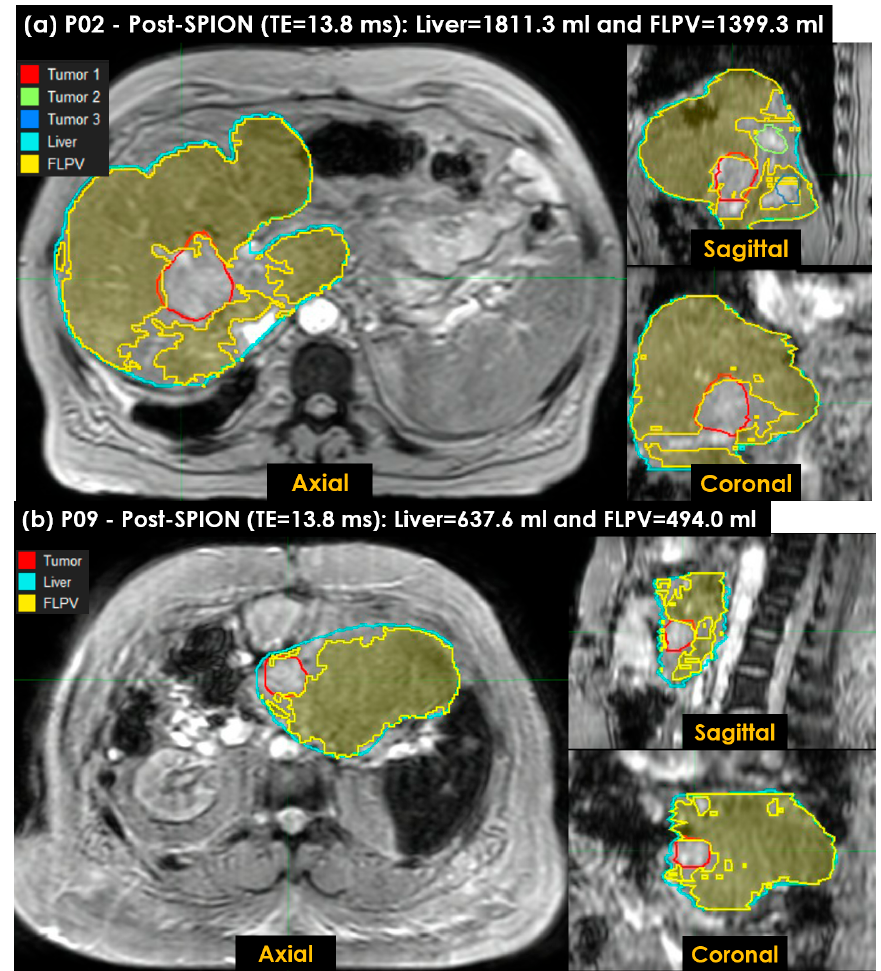
Figure 8. The functional liver parenchyma volume(s) FLPV(s), identified using the THRES-MEAN R2* of the second ONLY-POST R2* approach in an auto-contouring in-house tool, were overlaid on liver images. ( a ) Three tumors in patient P02, contoured in red (first tumor), green (second tumor) and blue (third tumor), are illustrated to demonstrate the efficiency of the in-house tool for identifying the FLPV; ( b ) a single tumor in patient P09, contoured in red, is also illustrated. Similarly, both the FLPVs of P02 and P09 are clearly distinguished from all tumors with minimal overlap between the FLPVs and non-FLPVs (tumor, hepatic vessels, liver fibrosis and scarring associated with hepatic cirrhosis). Table 2 shows the tumor and healthy liver volumes delineated by a physician as well as the FLPV(s) identified in both PRE-POST R2* and ONLY-POST R2* approaches across the 12 liver cancer